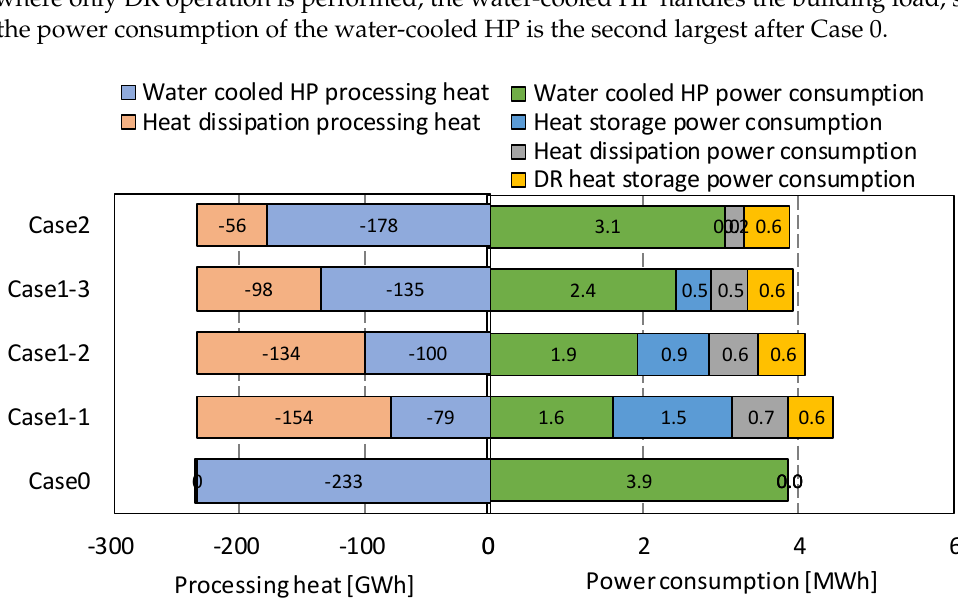
Figure 12. A comparison of operation transitions on the representative days of each case: ( a ) Wa- ter-cooled HP operation; ( b ) 10-hour nighttime heat storage operation and DR heat storage opera- tion; ( c ) 3-hour night heat storage operation and DR heat storage operation; ( d ) DR heat storage operation.